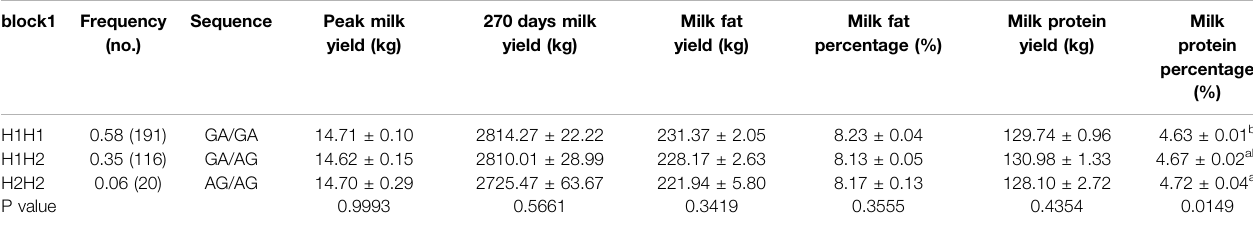
TABLE 2 | Assocation analysis between haplotypes of block 1 in the ACSL1 gene and milk production traits. block1 Frequency